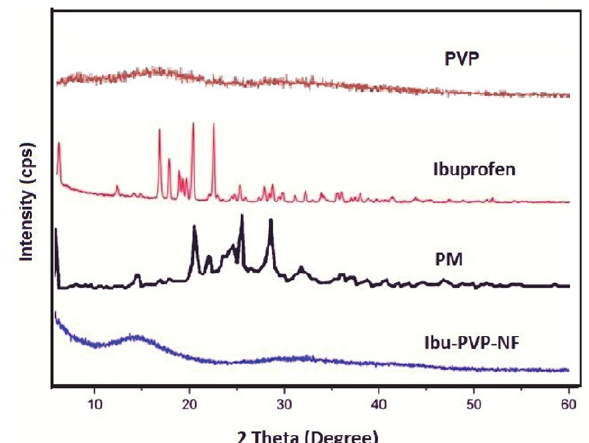
Fig 2. X-ray diffraction patterns of the studied samples indicated negligible or no crystallinity in the ibuprofen-loaded nanofiber sample (Ibu-PVP-NF). The raw ibuprofen (Ibuprofen) and physical mixture (PM) samples retained the crystalline peaks. PVP nanofib- ers (PVP) exhibited no crystalline peak indicating their amorphous